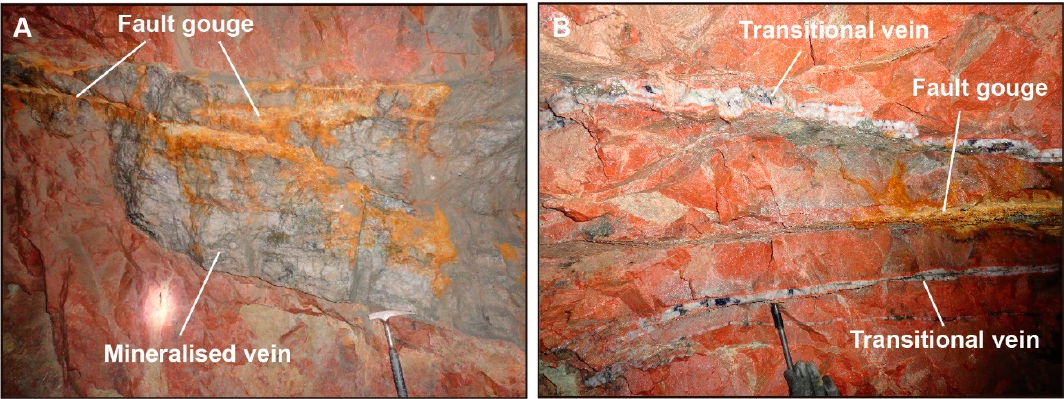
Figure 11. ( A ) Orebody with late fault gouge with an ochre colour; ( B ) Fault gouge associated with fault plane near transitional veins (see definition in [10]).